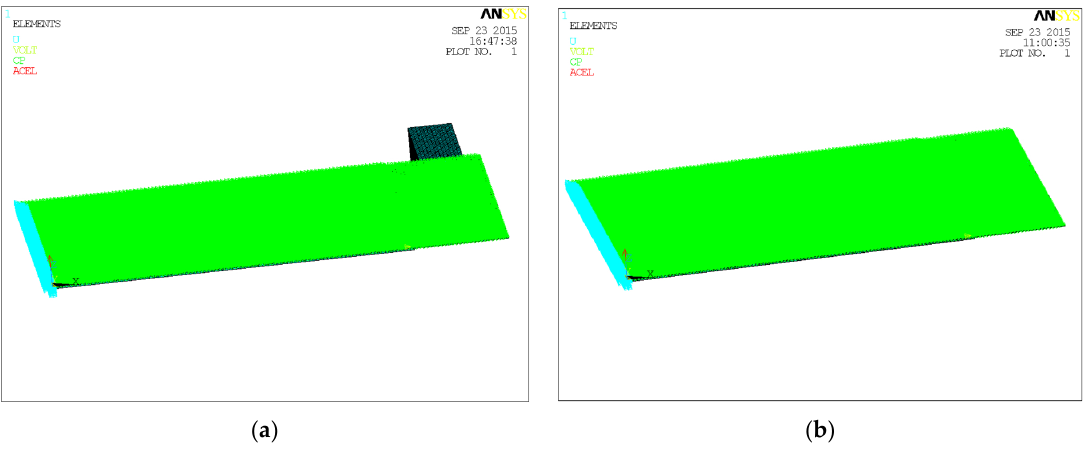
Figure 7. Models after meshing and defining constraints in cantilever beam fixation mode: ( a ) With mass block; ( b ) Without mass block.